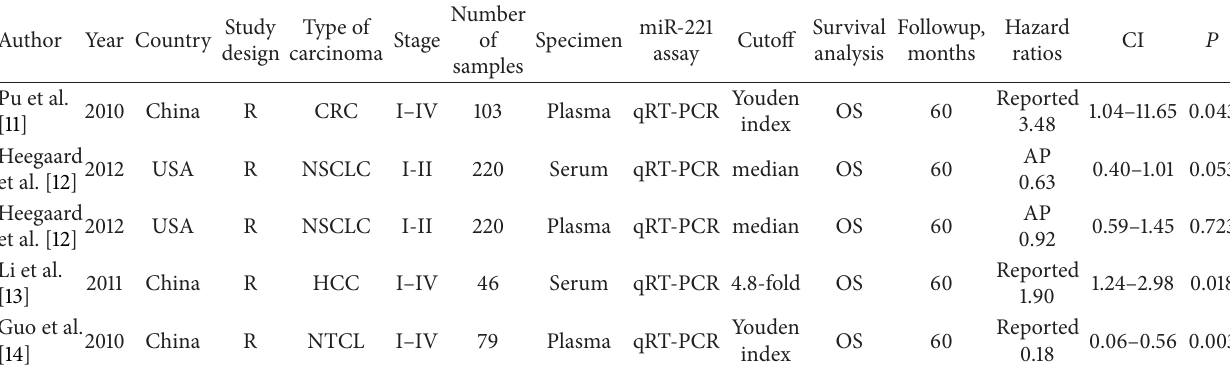
Table 1: Summary information of references included in the meta-analysis of miR-221 and survival.